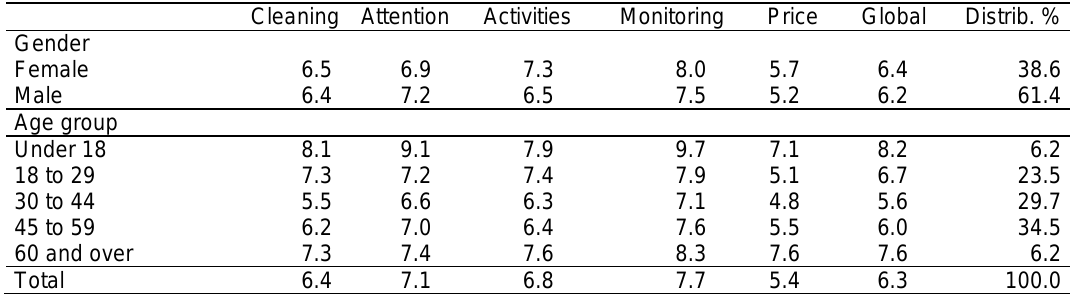
Table 11. Assessment of sports facilities by gender and age group (2017). L’Hospitalet Nord sports complex. Cleaning Attention Activities Monitoring Price Global Distrib.